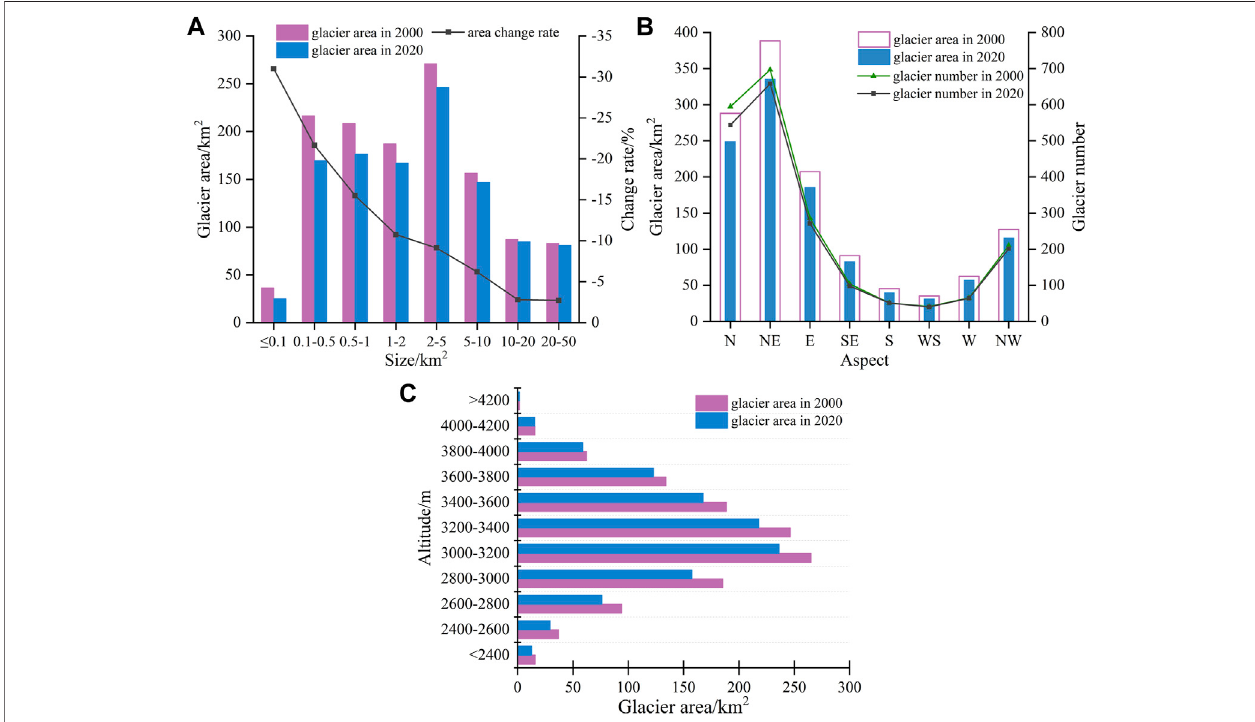
FIGURE 5 | (A) Glacier areas of different size classes in 2000 and 2020. (B) Glacier areas and the number of different aspects in 2000 and 2020. (C) Glacier areas within different altitude zones in 2000 and 2020.